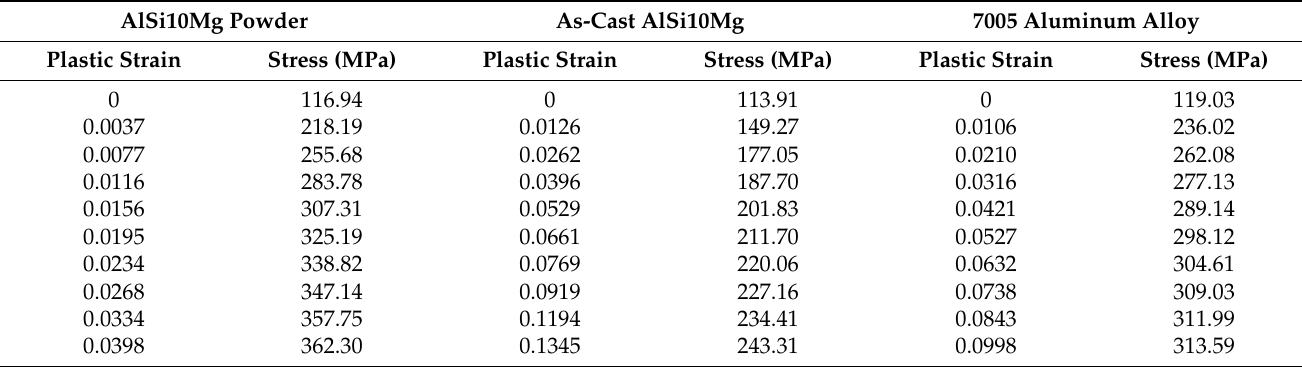
Table 2. Plastic parameters of three strut